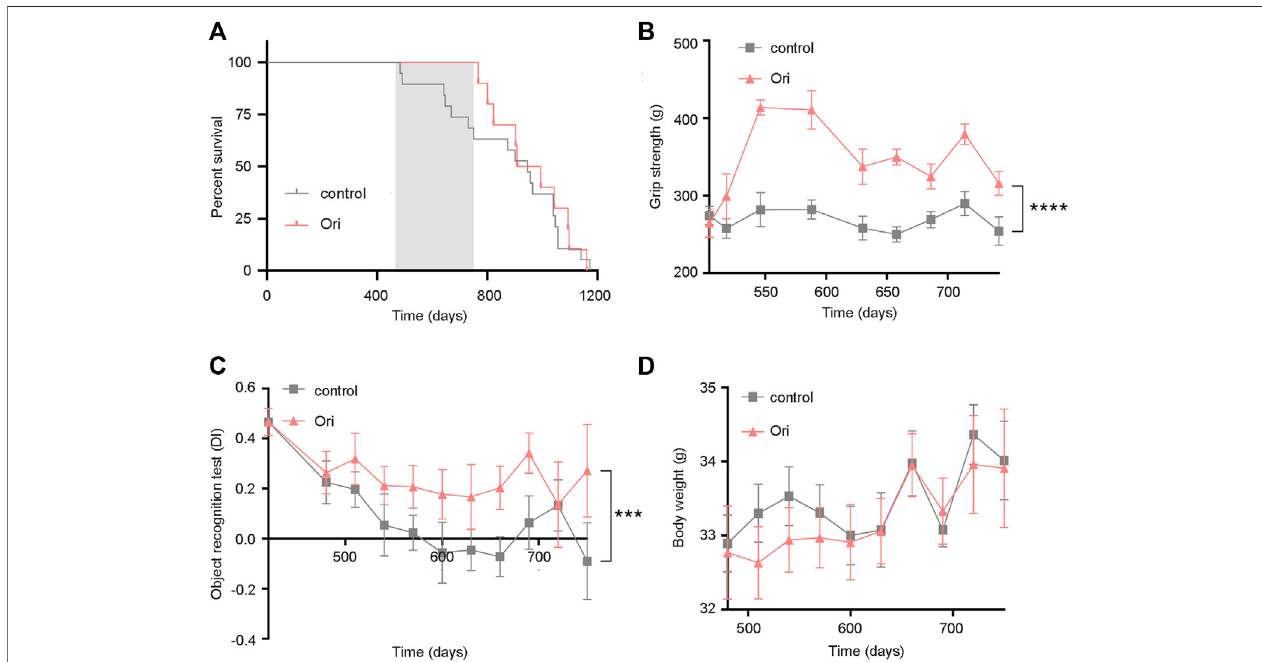
FIGURE3| Oridoninprolongsthelifespanofmiceandincreaseshealthylifespan.16-month-oldC57BL/6Jmiceweretreatedwithvehicleororidoninonceamonth for 6 months. (A) The survival curve of male mice treated with oridonin (Ori) (2 mg/kg) or vehicle control (the shadow is the period of administration. Control n = 19, oridonin 2 mg/kg n = 10). (B) Oridonin (Ori) (2 mg/kg) improves the grip of male mice (Control n = 19, oridonin 2 mg/kg n = 10). (C) Oridonin (Ori) improves the learning and memory ability of male mice (new object recognition experiment, DI: Discrimination index) (control n = 19, oridonin 2 mg/kg n = 10). (D) Detect the weight change of male mice under the intervention of oridonin (Ori) (2 mg/kg) (control n = 19, oridonin 2 mg/kg n = 10). Data represent the mean ± SEM. p values were determined by one-way ANOVA, two-way ANOVA or Student ’ s t-test . (* p < 0.05, ** p < 0.01, *** p < 0.001, **** p <